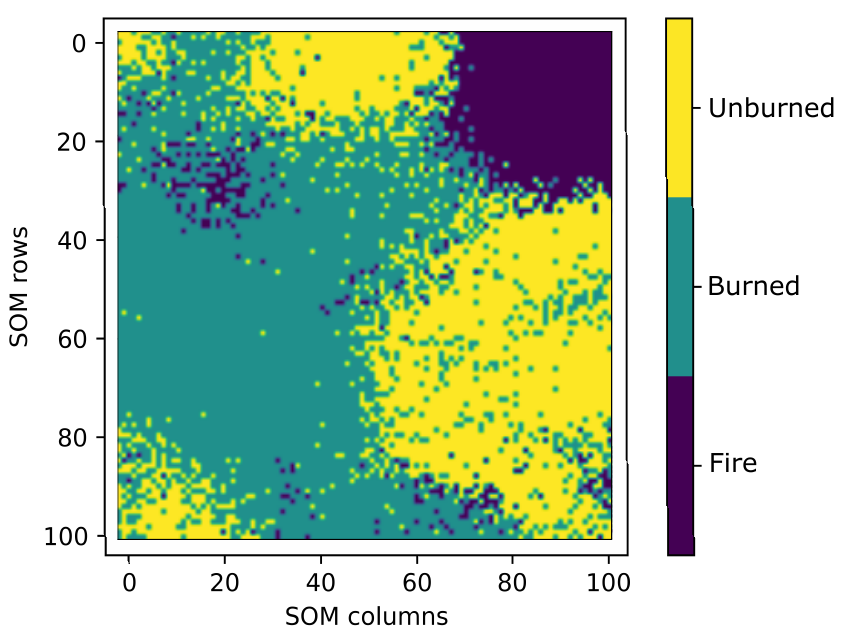
Figure 11. Visualization of the supervised classification SOM as the distribution of the classes linked to each SOM node as the output.